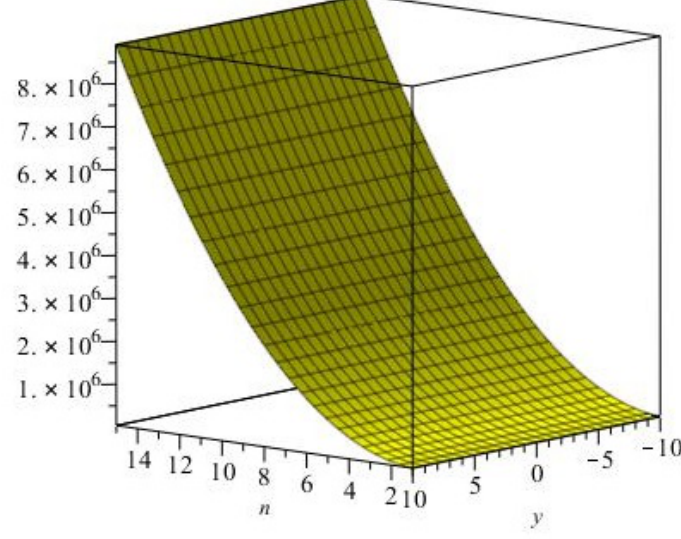
Figure 5. The graphical representation of the Connective Eccentric index.